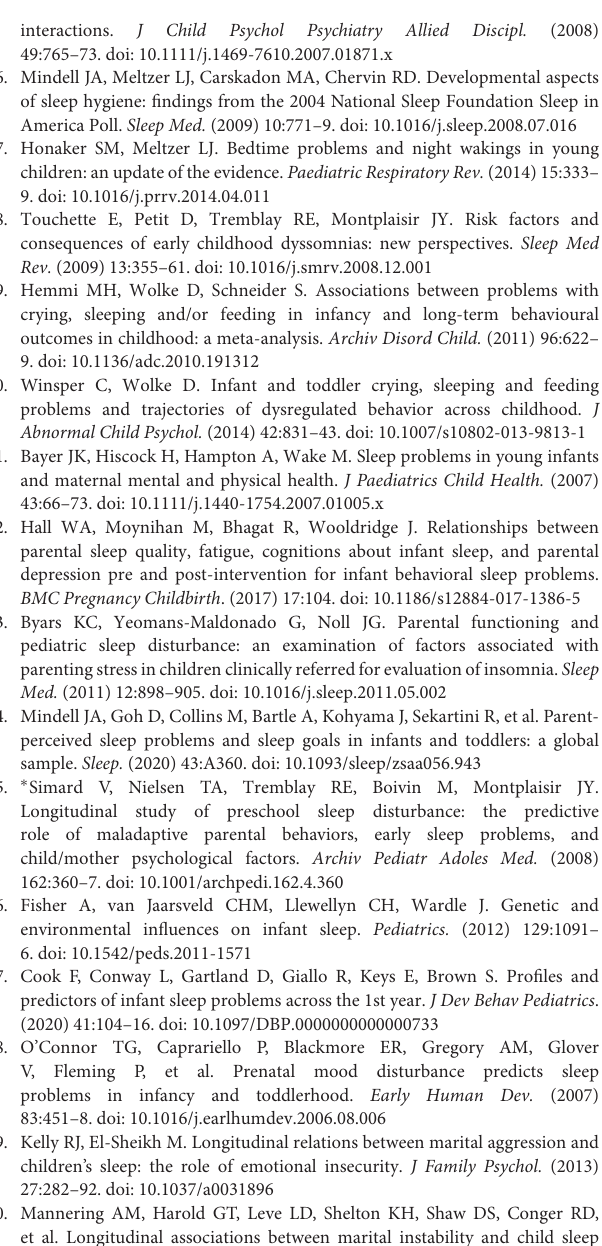
Supplementary Table 1 | Checklist of items to include when reporting a systematic review or meta-analysis. Supplementary Table 2 | Sleep-related cognitions—study sample and design